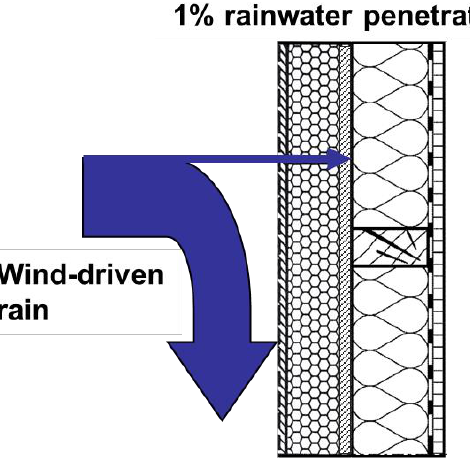
Figure 4. EIFS showing the deposit location of rainwater penetration through leaks.